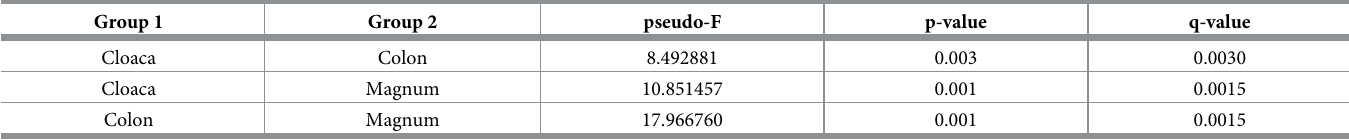
Table 4. Pairwise PERMANOVA results based on weighted unifrac distance matrix. Group